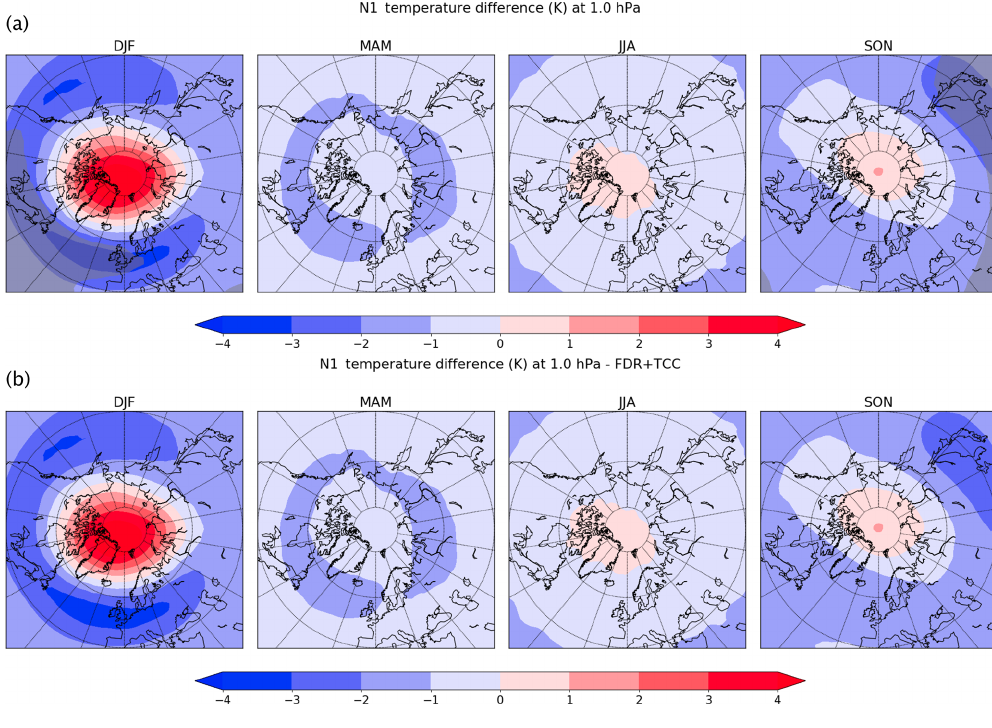
Figure 5. As Fig. 2 but for the 1hPa level.